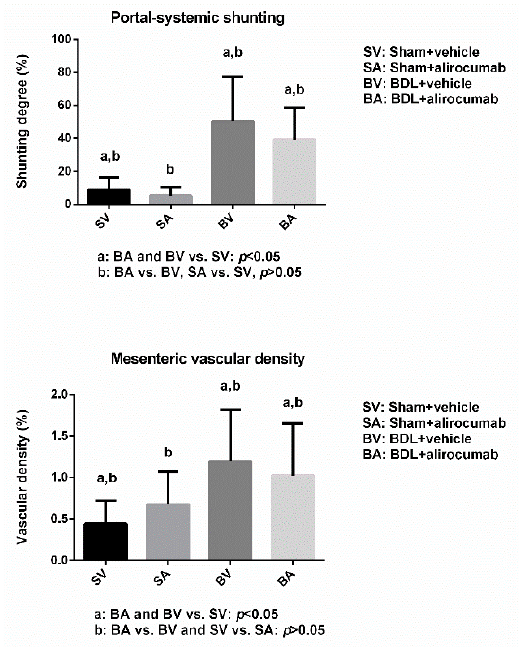
Figure 3. The portal-systemic collateral shunting and mesenteric vascular density of sham or BDL rats with or without alirocumab. The collateral shunting degree significantly increased in BDL rats compared to sham rats, which was not influenced by alirocumab, both in sham and BDL rats (Sham-V vs. Sham-A vs. BDL-V vs. BDL-A: n = 8:9:9:10; BDL-A and BDL-V vs. Sham-V, p < 0.05, BDL-A vs. BDL-V, p > 0.05, Sham-A vs. Sham-V, p > 0.05). Similarly, the mesenteric vascular density significantly increased in BDL rats, which was not influenced by alirocumab (BDL-A and BDL-V vs. Sham-V, p < 0.05, BDL-A vs. BDL-V, p > 0.05, Sham-A vs. Sham-V, p > 0.05).